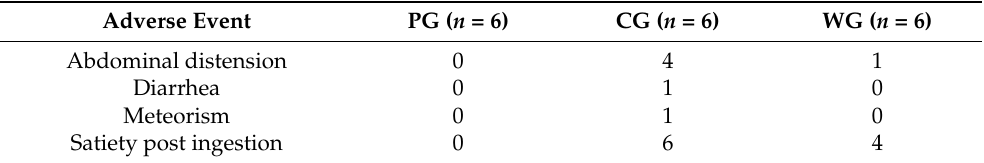
Table 3. Summary of adverse events and satiety in the placebo (PG), chia flour (CG), and whey protein (WG)